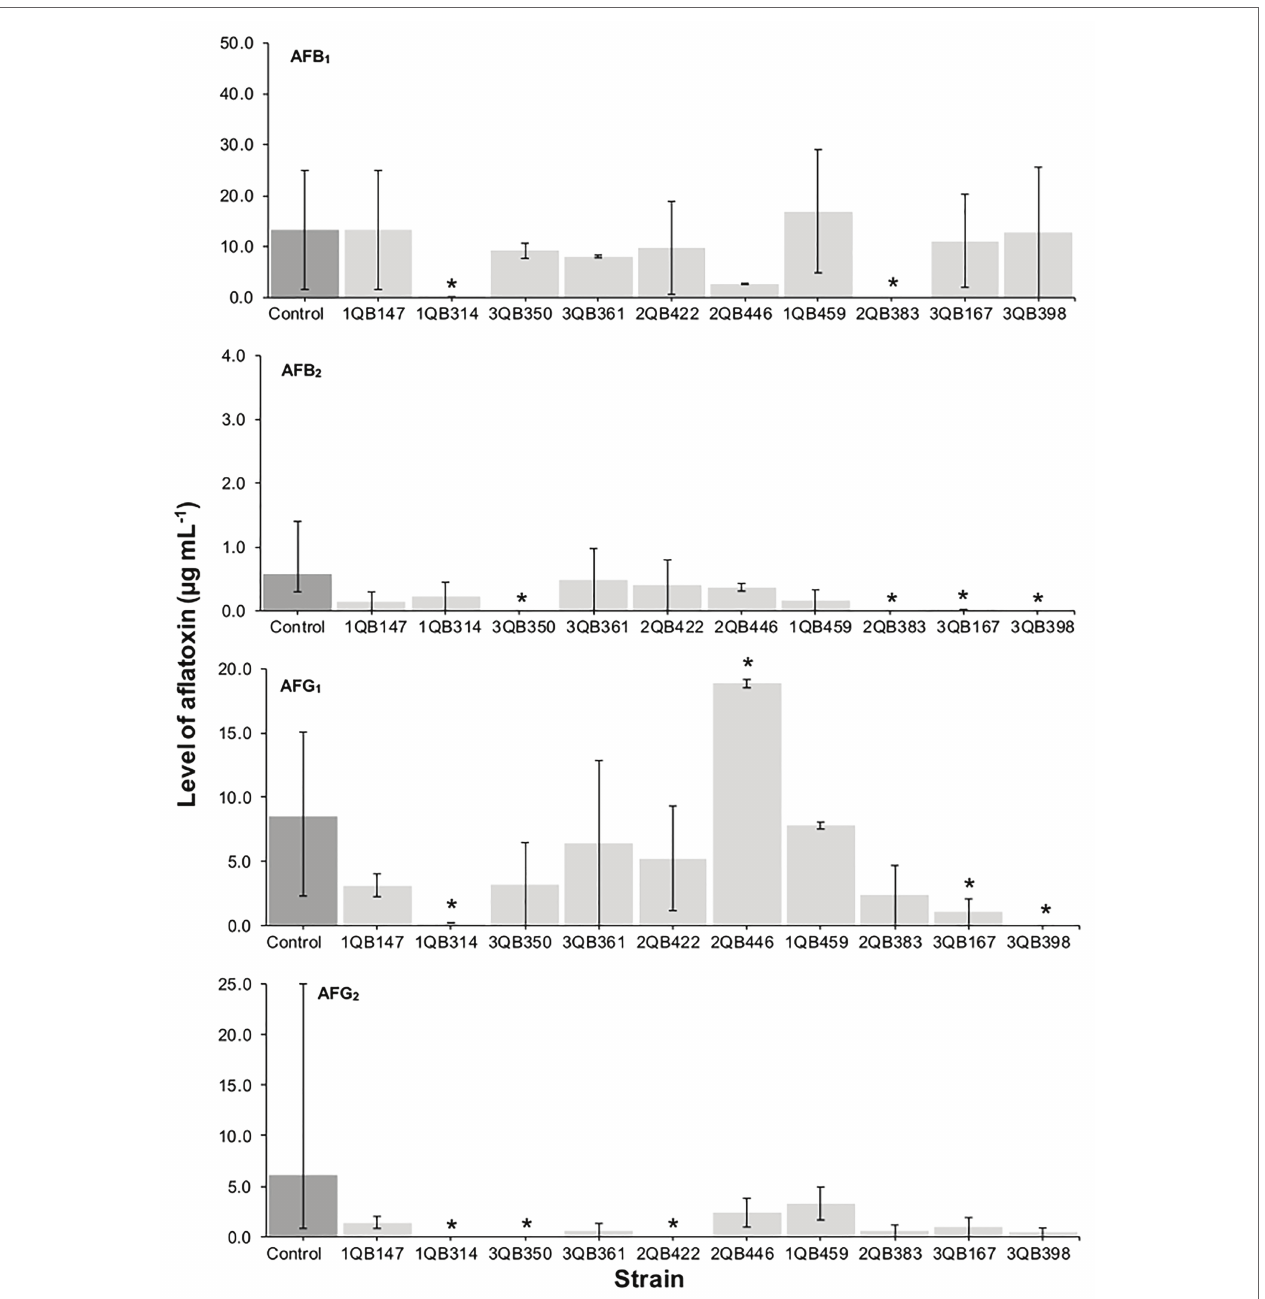
FIGURE 4 | Effect of LAB on production of AFB 1 , AFB 2 , AFG 1 , and AFG 2 by A. parasiticus NRRL 2999 in co-cultured YES broth after 7 days of incubation at 25 ° C. LAB was inoculated (5 log 10 cfu ml −1 ) after 48 h (Inoculation = T 48 h) incubation of the fungus. The individually tested LAB included: four strains of Lactiplantibacillus plantarum (former Lactobacillus plantarum , comprising strains 1QB147, 1QB314, 3QB350, and QB361), two strains of Levilactobacillus brevis (former Lactobacillus brevis , comprising strains 2QB422 and 3QB446), and four strains of Levilactobacillus spp. (former Lactobacillus sp., comprising strains 1QB4593, 2QB383, 3QB167, and QB398). Results are expressed as median values of three independent experiments, with minimum and maximum values indicated as error bars. *Median values with asterisks differ significantly from controls ( p <